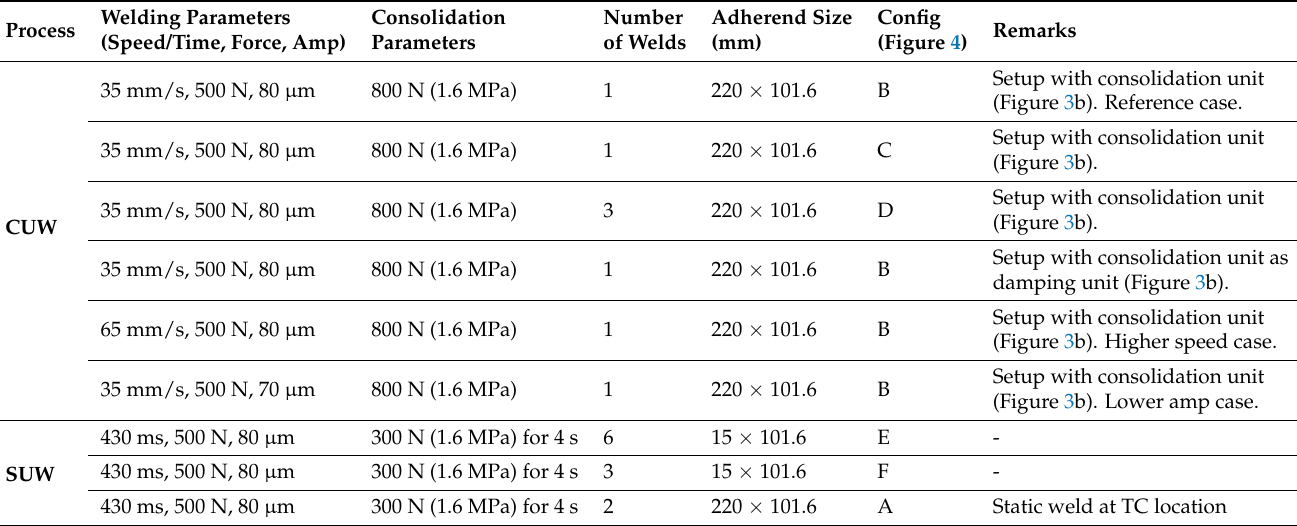
Table 1. Overview of Continuous (CUW) and Static (SUW) Ultrasonic Welding Experiments (Note: the amplitude (amp) values are